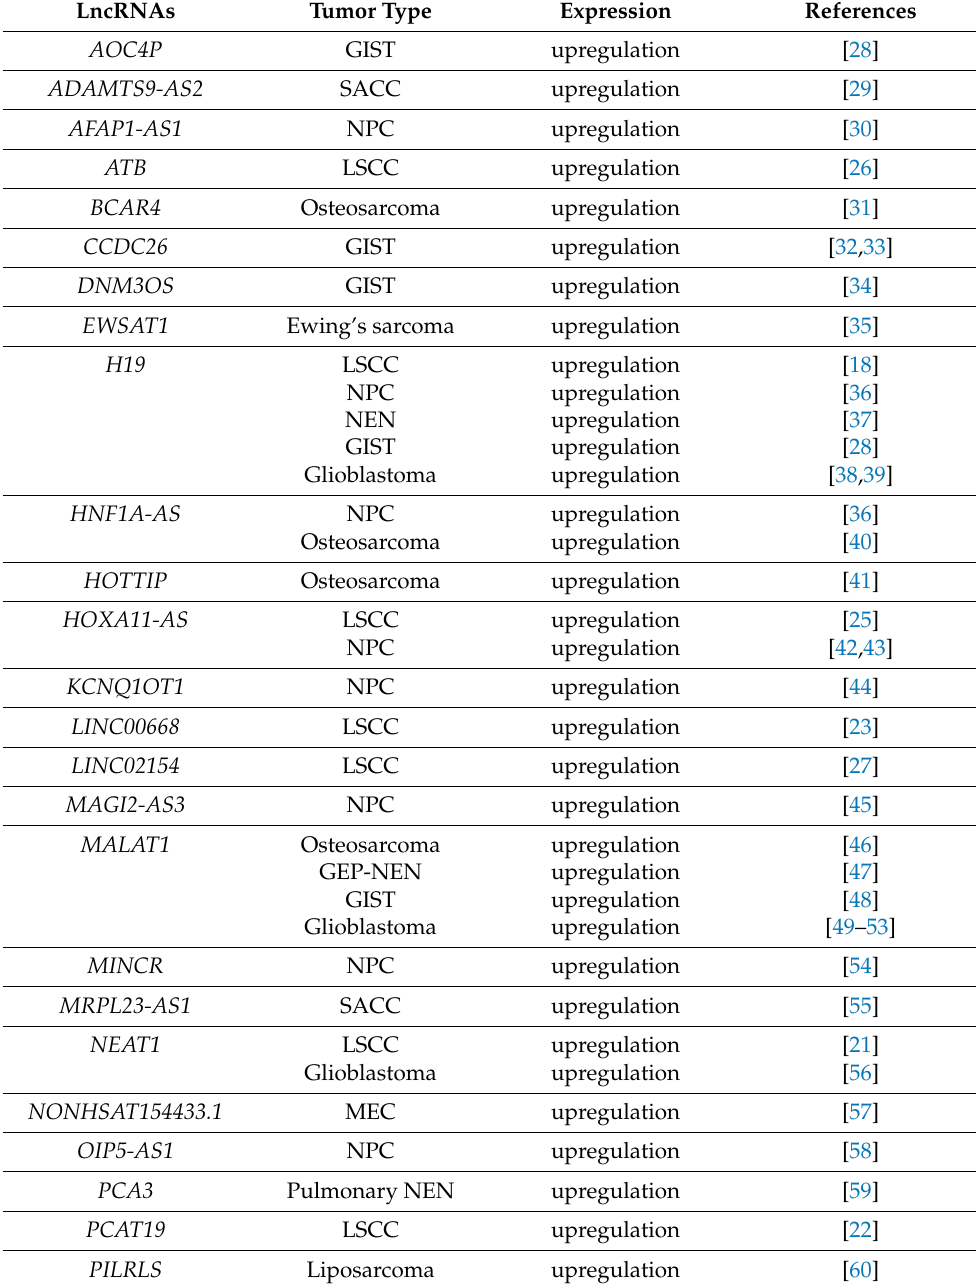
Table 1. Main lncRNAs described in rare cancers. LncRNAs Tumor